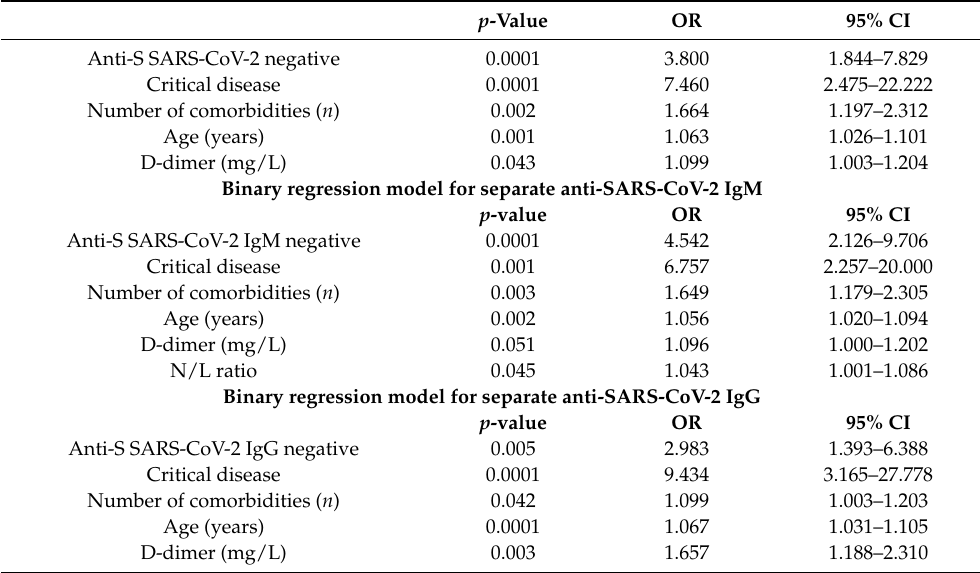
Table 3. Binary logistic regression analysis of the association of in-hospital death with anti-S SARS-CoV-2 negativity and other variables. p -Value OR 95%